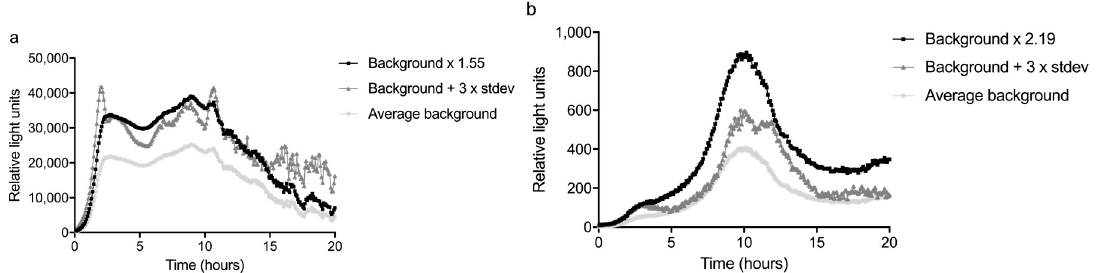
Figure 4. An overview of the average background of three experiments performed in the laboratory with tap water to determine the normal background response of the sensor. Shown are the background + three times standard deviation and the background x the highest response ratio between 2 and 10 h. This ratio was 1.55 for the glass slide ( a ) and 2.19 for the fiber ( b ).